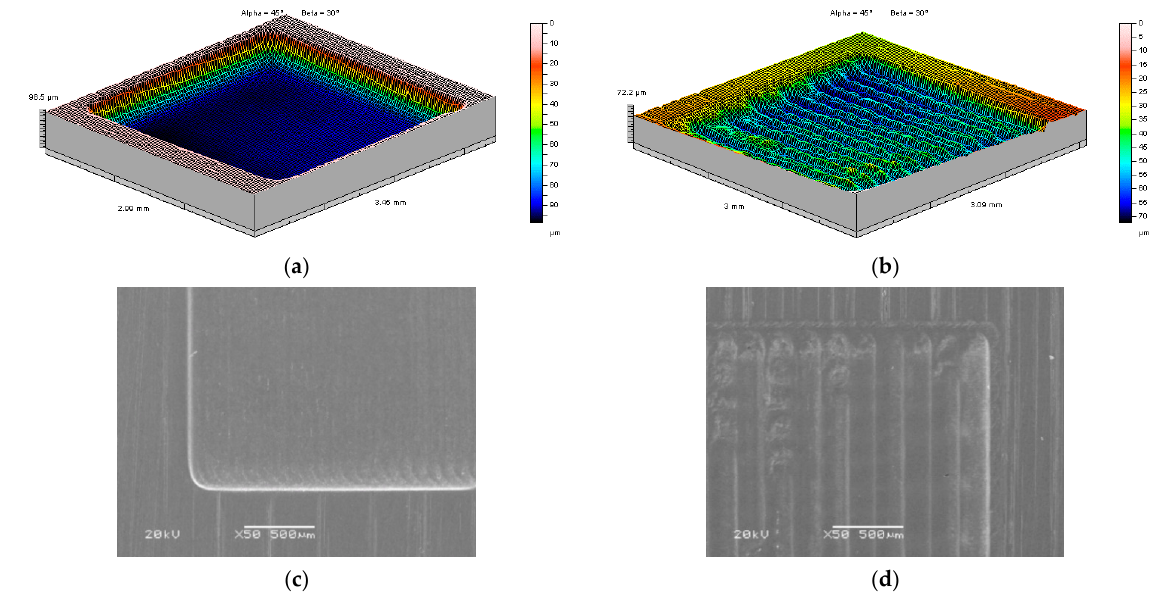
Figure 15. Three dimensional profiles and SEM photographs of the electrochemically milled cavities for different distances between electrode tool passes: ( a ) c = 50 μ m ( c / D = 0.25), depth 98.5 μ m and ( b ) c = 200 μ m ( c / D =1), depth 72.2 μ m; ( c ) SEM photo of left bottom corner of cavity ( a ), ( d ) SEM photo of right top corner of cavity ( b ).